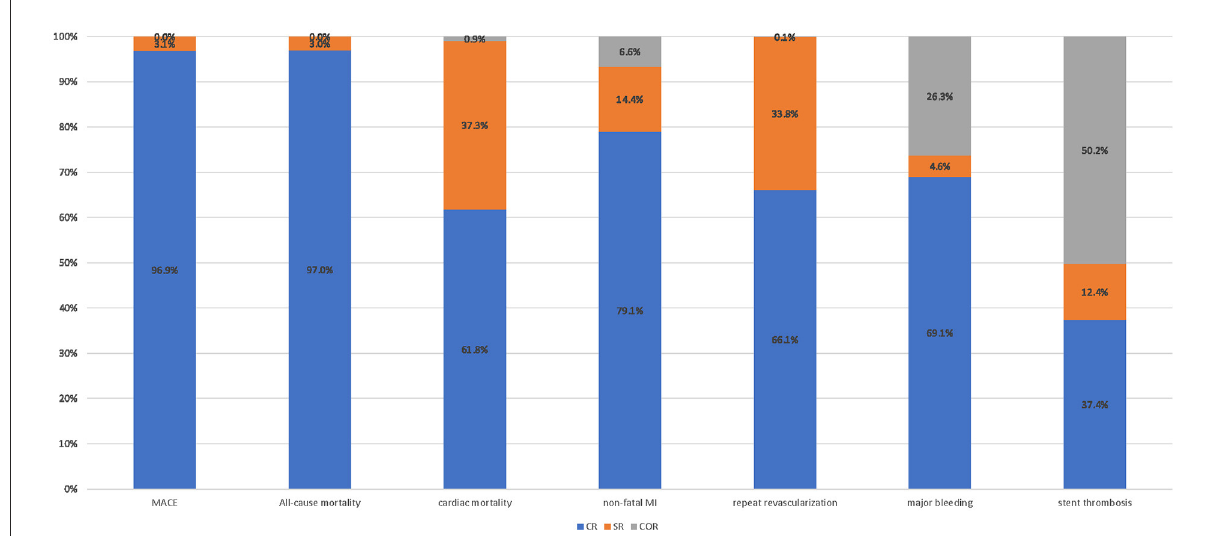
FIGURE6 Probability ranking plot of each strategy. Probability ranking plot of three revascularization strategies. MACE, major adverse cardiac event (s); MI, myocardial infarction; OR, odds ratio; CR, complete revascularization at the time of primary PCI; SR, complete revascularization as a staged procedure; COR, culprit-only